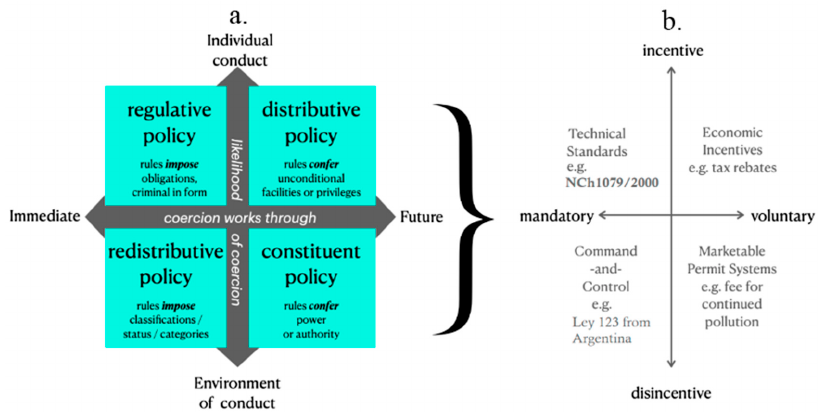
Figure 3. Lowi’s framework ( a ) and our own framework ( b ) to classify and evaluate green building rules.